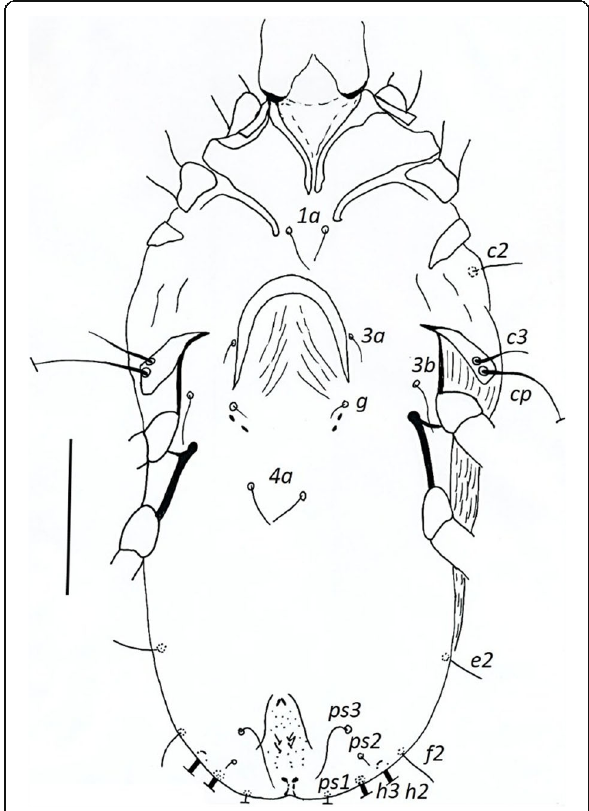
Fig. 4 Gabucinia delibata (Robin), female venter (scale bar, 100 μ